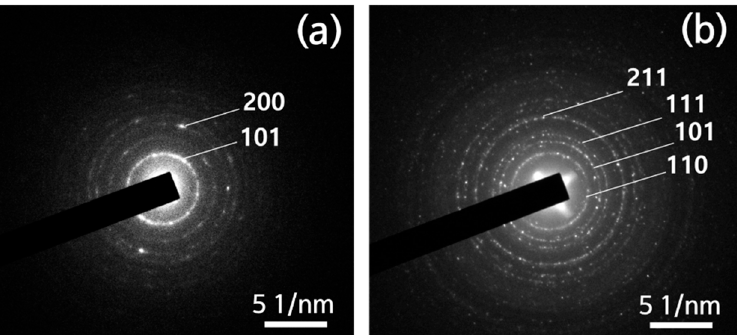
Figure 6. Selected area electron diffraction patterns obtained from nanofibers: ( a ) TiO 2 nanofibers and ( b ) Fe-doped TiO 2 nanofibers.